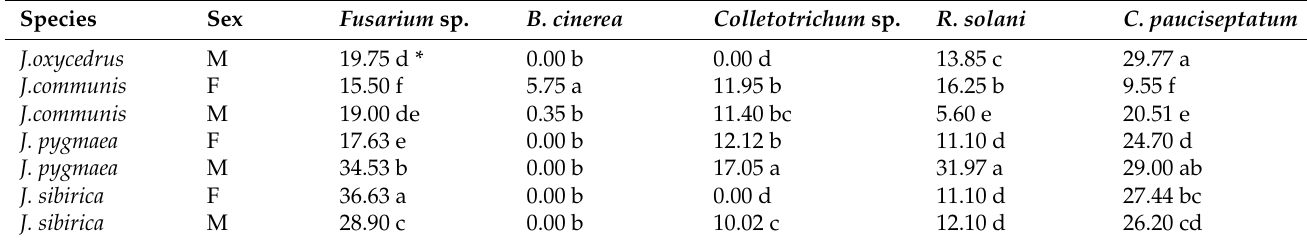
Table 8. Inhibitory effect (%) of juniper essential oils on plant pathogenic fungi at concentration of 1 µ L/mL. Species Sex Fusarium sp. B. cinerea Colletotrichum